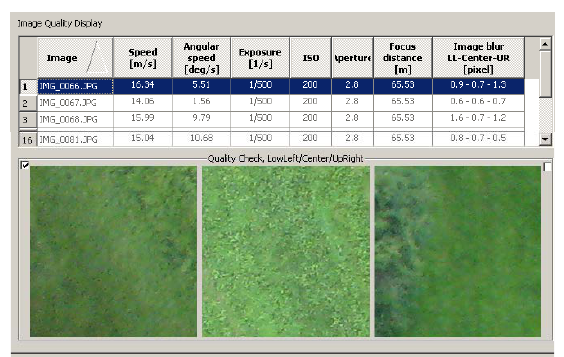
Figure 2: Image quality check in AirMosaic software. The